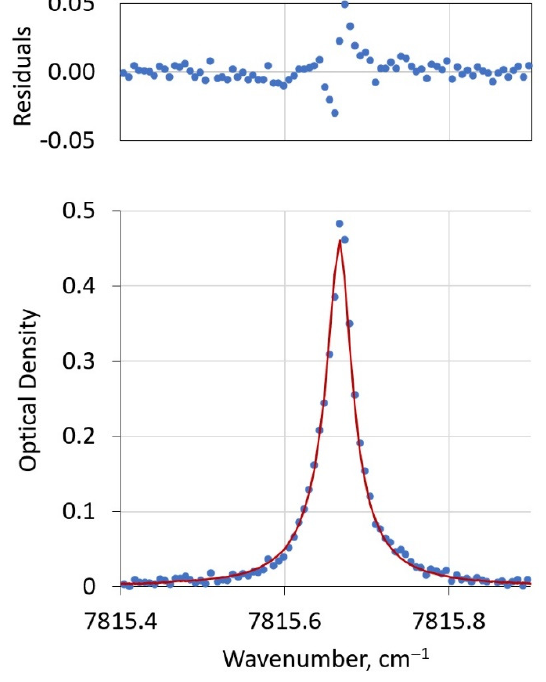
Figure 6. Lower panel: representative fit of PHOCS oxygen line. Experimental data are shown as blue symbols. The red solid curve is the modeled spectrum. The upper panel shows the residuals of the fit. The instrument resolution, 200 MHz or 0.067 cm − 1 , is the spacing between experimental (blue) points.